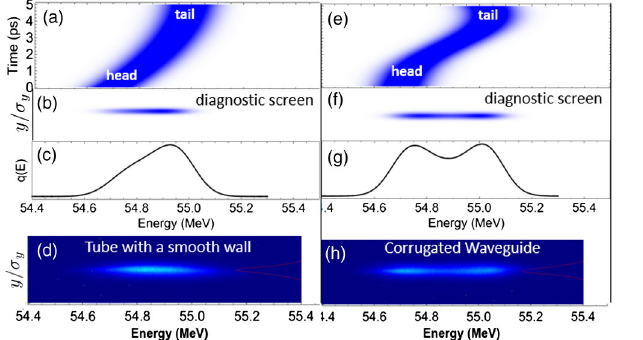
FIG. 15. Comparing measurements and simulations for the cases of the electron bunch propagating the tube with smooth wall (left column of plots) and the corrugated waveguide with L ¼ 74 mm (right column of plots). Plots (a) and (e) show the simulated distribution of electrons in the longitudinal phase space using energy on the horizontal axis and time on the vertical axis. Plots (b) and (f) show the simulated bunch image on the diagnostic screen using energy on the horizontal axis and the vertical coordinate y normalized on the rms vertical size σ vertical axis. Plots (c) and (g) show the simulated bunch energy distribution using energy on the horizontal axis and the charge in arbitrary units on the vertical axis. Plots (d) and (h) are similar to plots (b) and (f) and show the measured bunch image on the diagnostic screen using energy on the horizontal axis and the normalized vertical coordinate on the vertical axis.